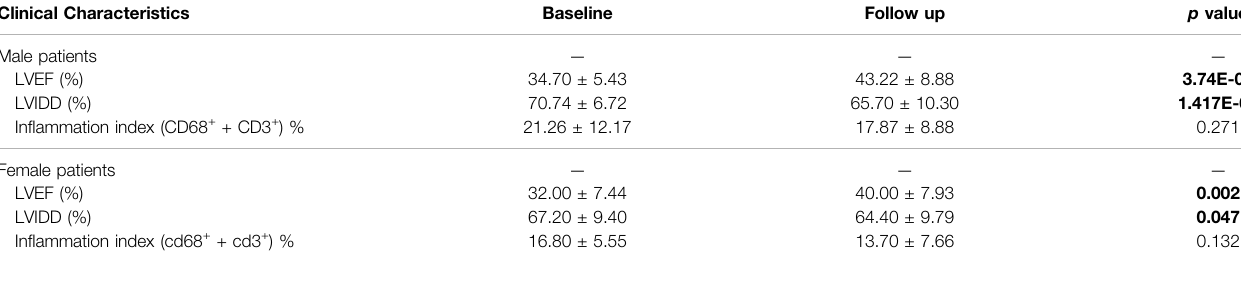
TABLE 1 | Correlations between IA/IgG immunotherapy and clinical features of DCM in male and female patients. Clinical